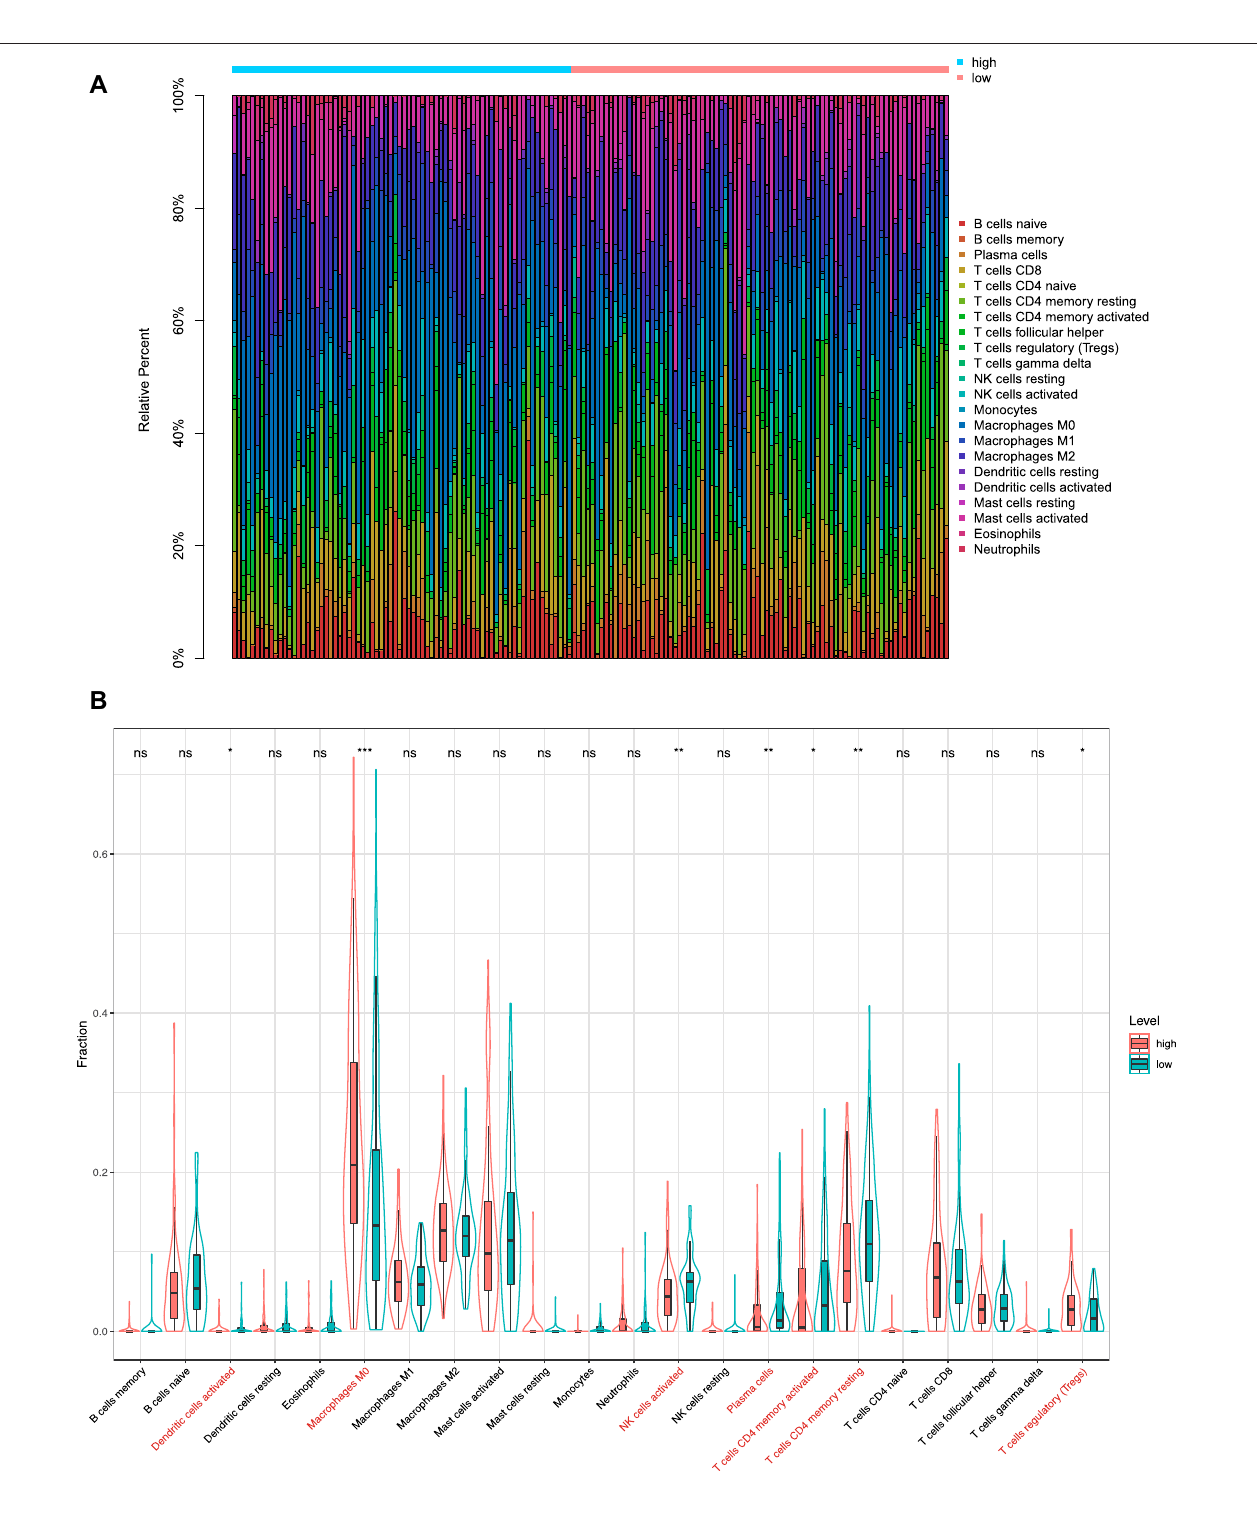
FIGURE9| Immunityanalysis via CIBERSORT. (A) Bargraphshowingtheproportionof22immunecelltypesinCCpatientsofTCGA-COAD.Columnnamesofthe plotarethesampleID. (B) Differenceintheproportionsof22immunecelltypesbetweenpatientsinthehigh-riskandlow-riskgroups.* p < 0.05;** p < 0.01;*** p < 0.001; and **** p < 0.0001; ns, not signi fi